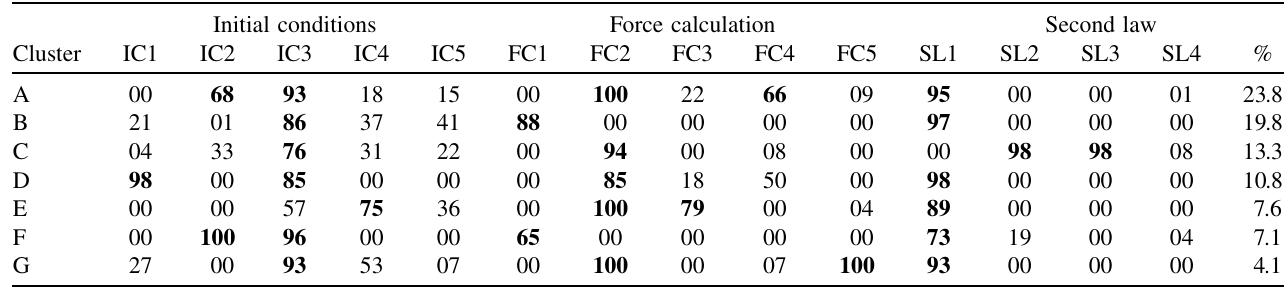
TABLE VI. Only seven of the 30 clusters with an intercluster distance of less than 0.5 were populated by more than 3% of the students. The bottom 18 clusters were populated by less than 1% of students each. These seven clusters accounted for 86.5% of students. The percentage of affirmatives for each code (Table II) within any given cluster (A–G) is given to the nearest whole percentage. Codes with affirmative percentages greater than 60% are in bold font. These clusters had very few students ( < 1% ) with any affirmatives in the ‘‘Other’’ category; hence, the results from this category are not reported. The percentage of students in each cluster is indicated in the last column